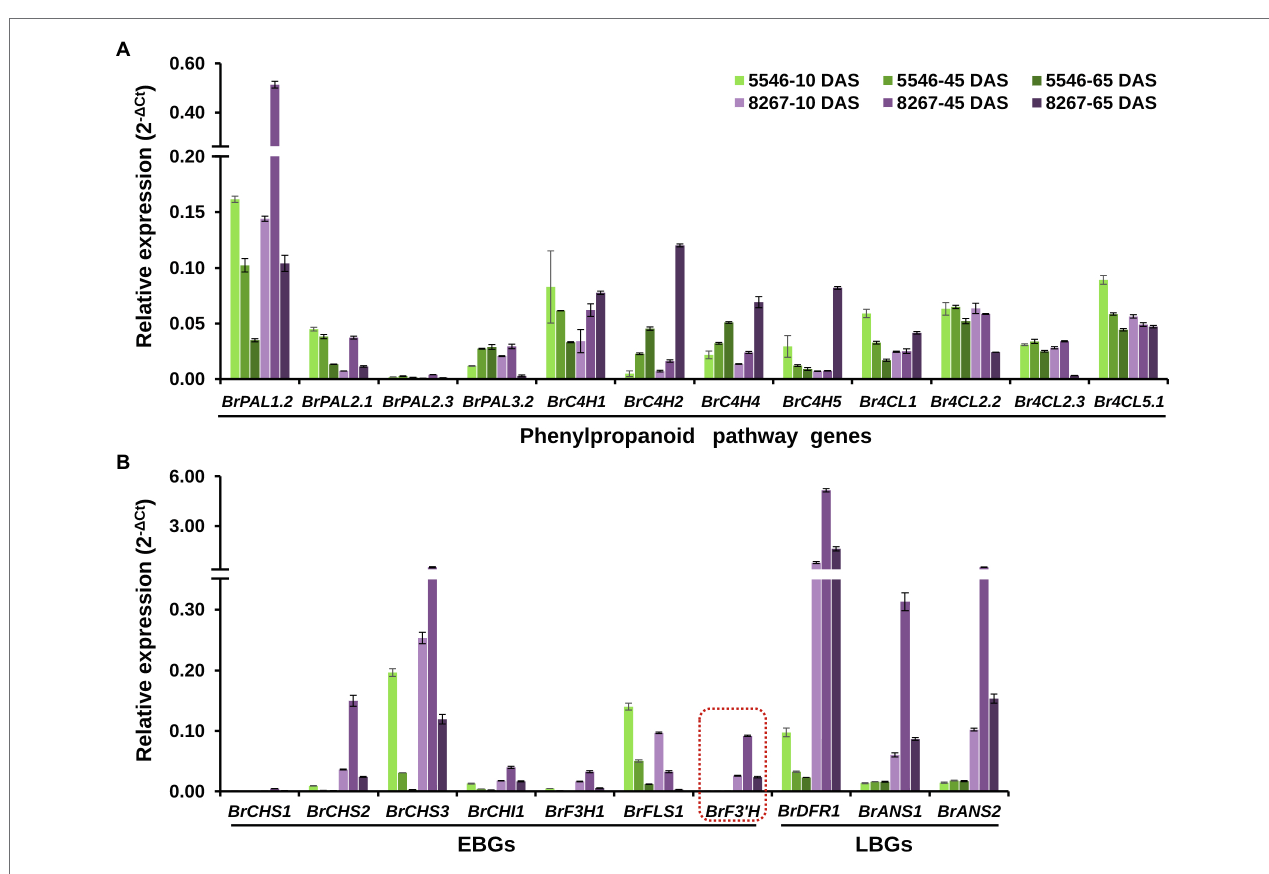
FIGURE 3 | qPCR analysis of the early and late flavonoid biosynthetic genes. Relative expression levels of the (A) phenylpropanoid pathway genes ( BrPAL , phenylalanine ammonia-lyase; BrC4H , cinnamate 4-hydroxylase; Br4CL , 4-coumaroyl:CoA-ligase), (B) early ( BrCHS , chalcone synthase; BrCHI1 , chalcone isomerase 1; BrF3H1 , flavanone 3 β -hydroxylase 1; BrFLS1 , flavonol synthase 1; BrF3 ′ H , flavonoid 3 ′ -hydroxylase) and late ( BrDFR , dihydroflavonol 4-reductase; BrANS , anthocyanidin synthase) flavonoid biosynthetic genes in leaves of the two varieties at different growth stages. Error bars indicate ± SD from three replicates. DAS, days after